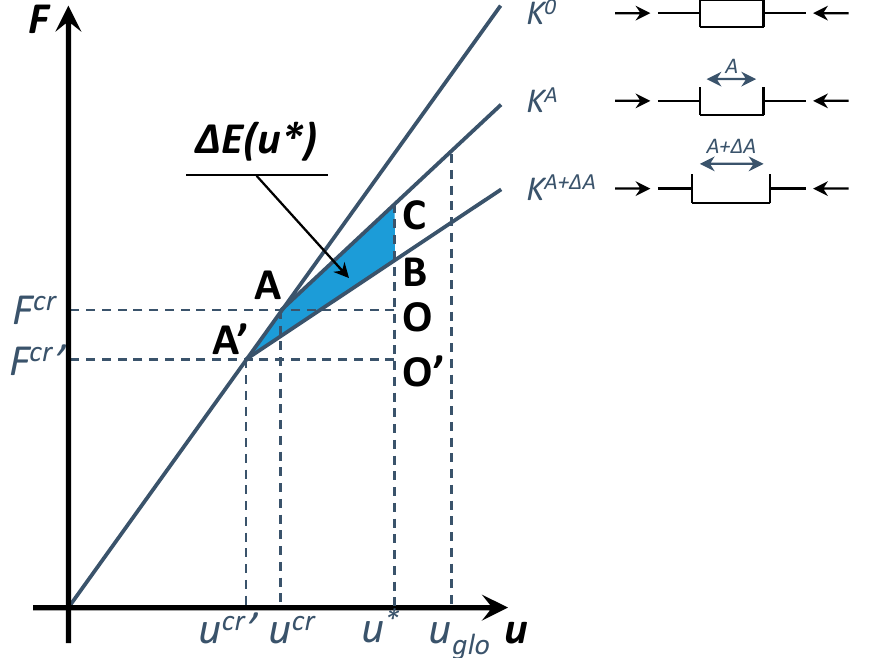
Figure 3. Schematic rapresentation of energy relase rate evaluation considering mode I and mode II interaction: u* < u glo .